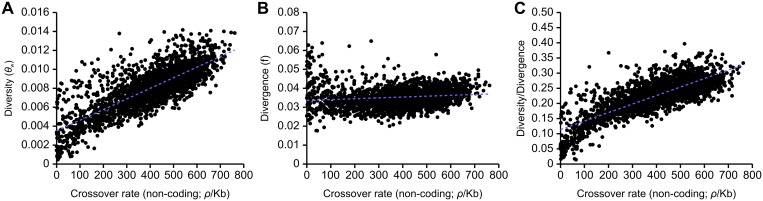
Correlations between estimates of non-coding genetic diversity and divergence with population recombination rates inferred with LDHAT.(A) Correlation between recombination and diversity (R2 = 0.615, p<10-5). Linear regression: f(x) = (1.118×10-5)x + (3.517×10-3). (B) Correlation between recombination and divergence between A. mellifera and A. cerana (R2 = 0.0185, p<10-5). Linear regression: f(x) = (4.439×10-6)x + (3.360×10-2). (C) Correlation between recombination and diversity/divergence (R2 = 0.617, p<10-5). Linear regression: f(x) = (2.801×10-4)x + (1.140×10-1). 100 kb genomic windows are used in each comparison.